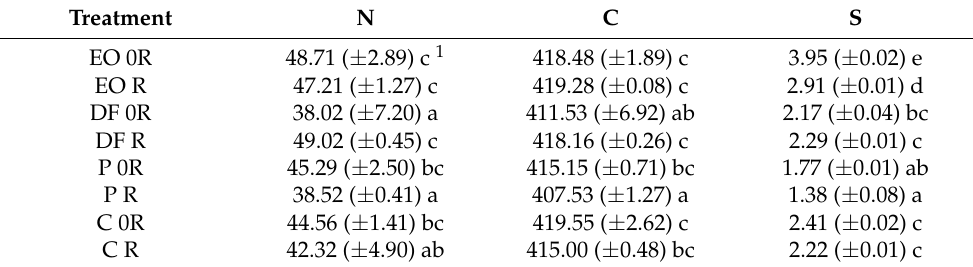
Table 5. The effect of PDSs and bioremediation on the content of nitrogen, carbon and sulfur in the leaves of Vicia faba L. (g kg − 1 ).